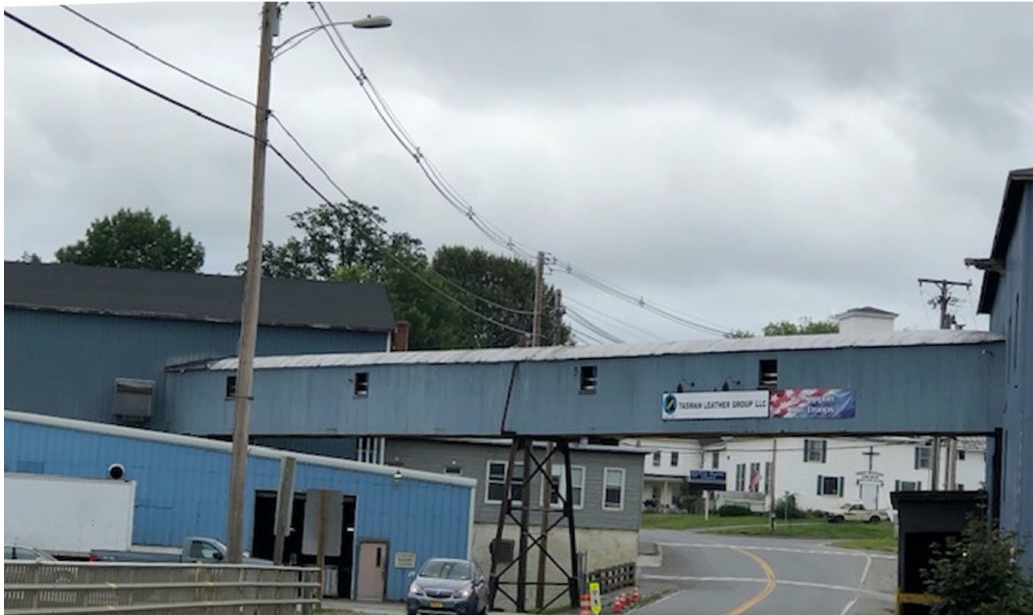
Figure 12. From transect across Central Maine: Stage 3–Treading Water. Route 43 passing through the Tasman tannery complex in Hartland, Maine. (Photo courtesy of Betty